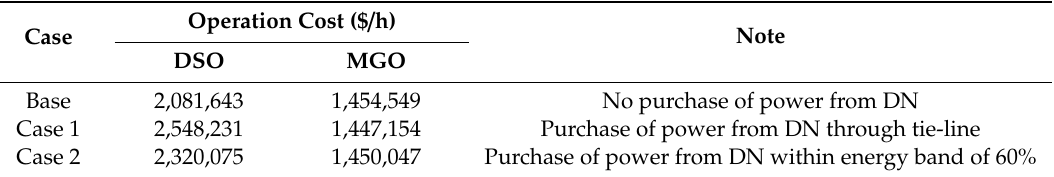
Table 8. Comparison of operational costs for each Scenario in Case 2.